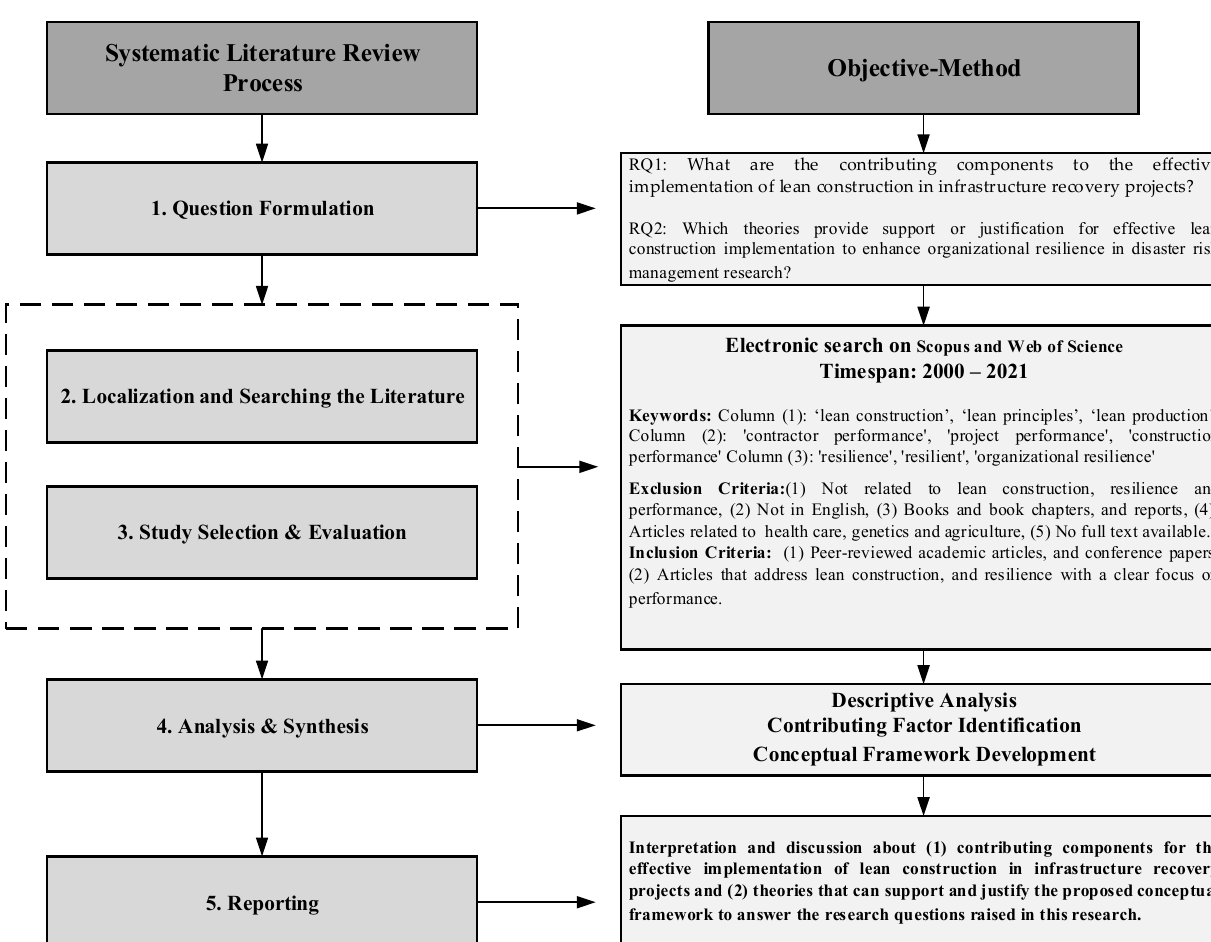
Figure 1. Summary of the systematic literature review.